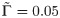
Illustration of finite size effects in the shock phase, based on the density profile for Γ˜=0.05, α˜=0.2, β˜=0.16 and L = 1.The blue dots represent the numerical results for N = 500 sites,whereas red dots are for N = 1000 sites. The solid black line corresponds to the analytical solution.